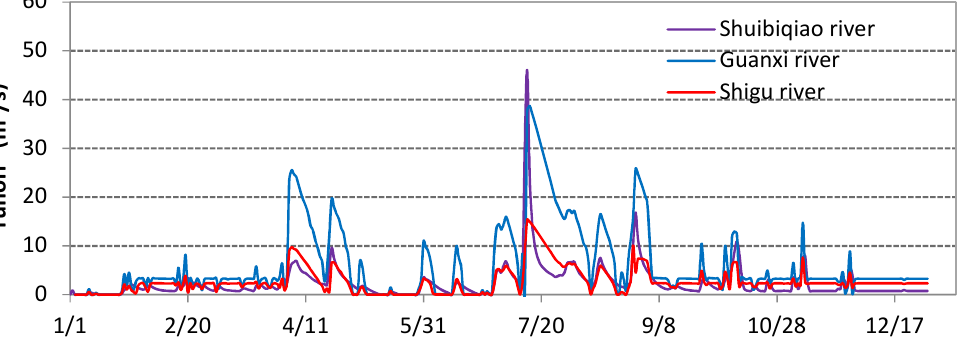
Figure 9. Runoff variation of river channels in a dry year (95%).